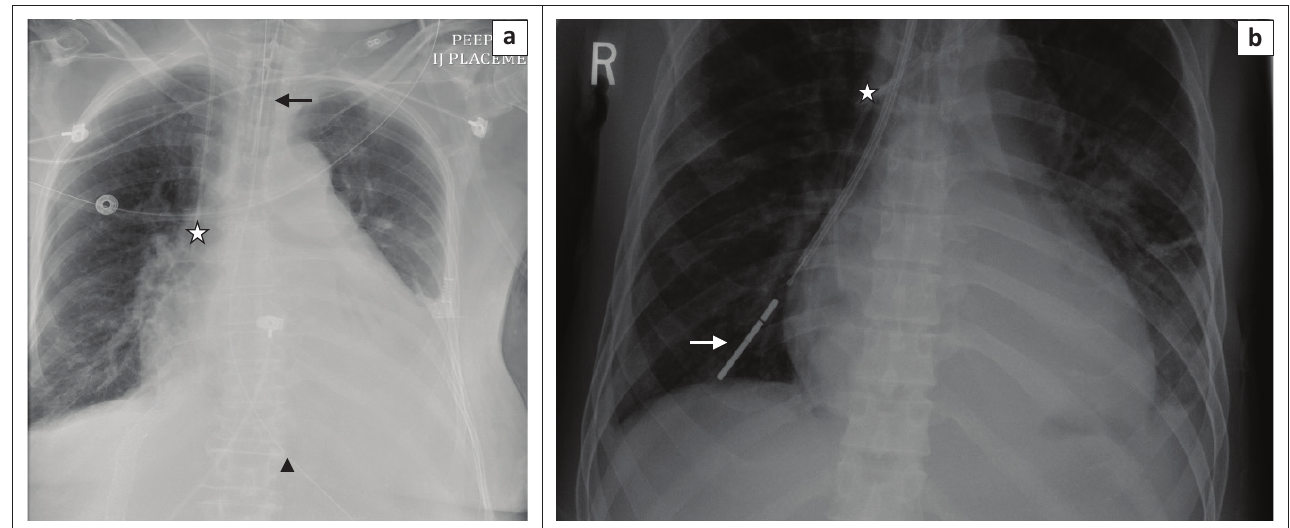
FIGURE 3: (a) Chest radiograph showing an accurately positioned nasogastric tube with its proximal side hole (arrowhead) and tip located beyond the gastroesophageal junction. In addition, an endotracheal tube (black arrow) and a right internal jugular vein central venous catheter (star) are noted on this chest radiograph; (b) a malpositioned Dobhoff tube (white arrow) in the right main bronchus. Additionally, a left central venous catheter (star) is noted with its tip in the superior vena cava.